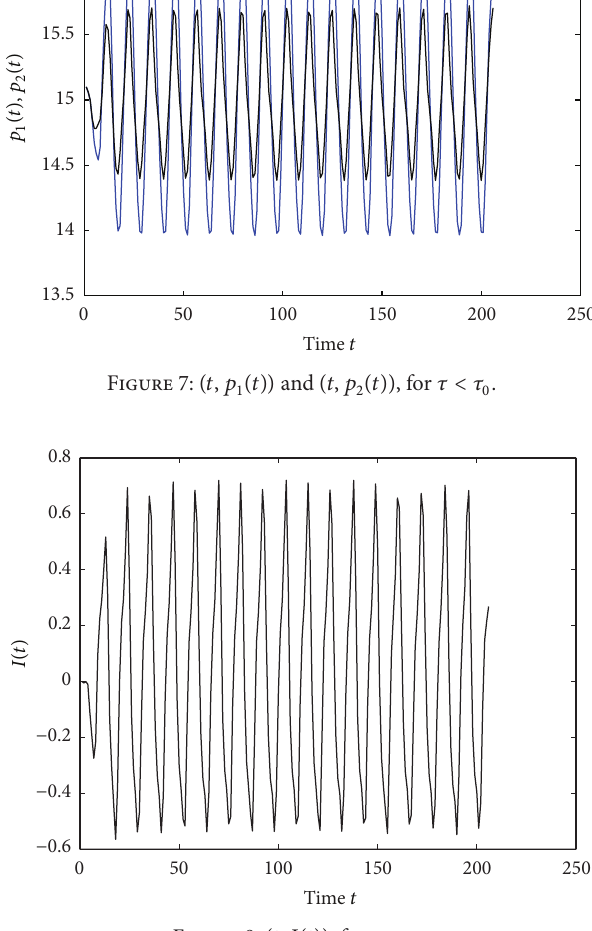
Figure 5: (𝑡,𝑝 1 (𝑡)) and (𝑡,𝑝 2 (𝑡)) , for 𝜏 > 𝜏 0 .